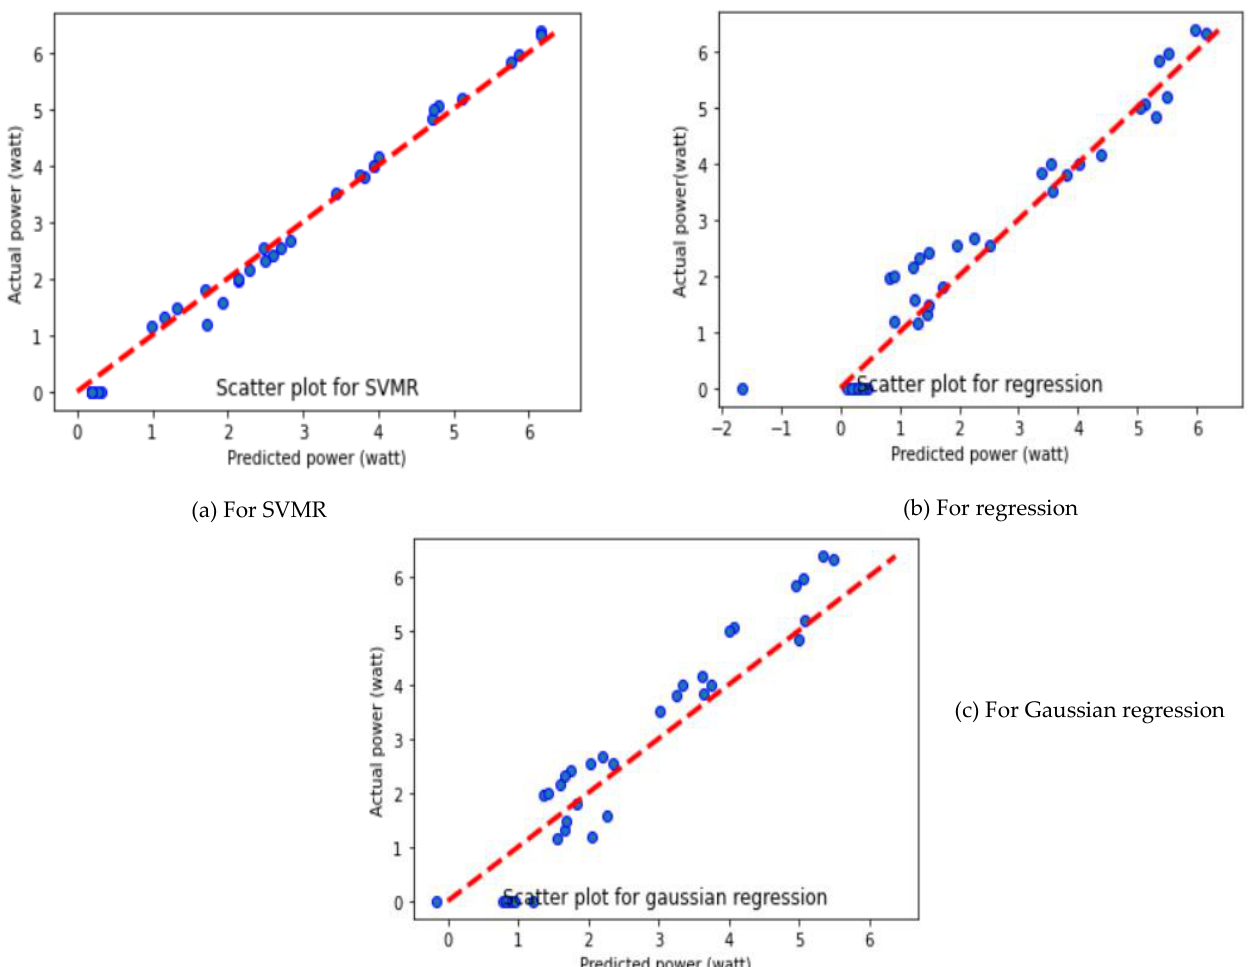
Figure 3. Prediction of output power of solar PV panel using different ML algorithms for Fold-1.